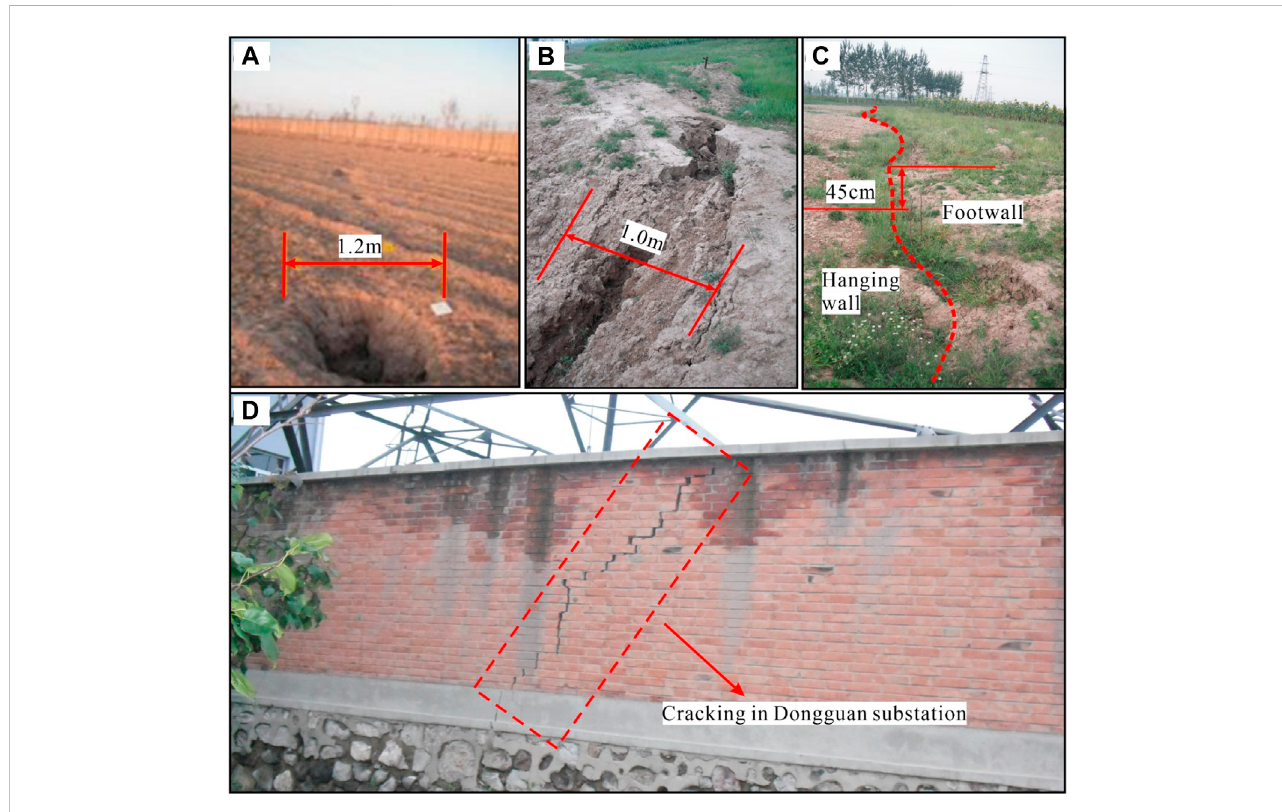
FIGURE 2 Surface morphology and hazards of TY3 ground fi ssures in Dongguan substation. (A) Beaded pits; (B) Horizontal cracks; (C) Vertical dislocation; (D) Substation enclosure